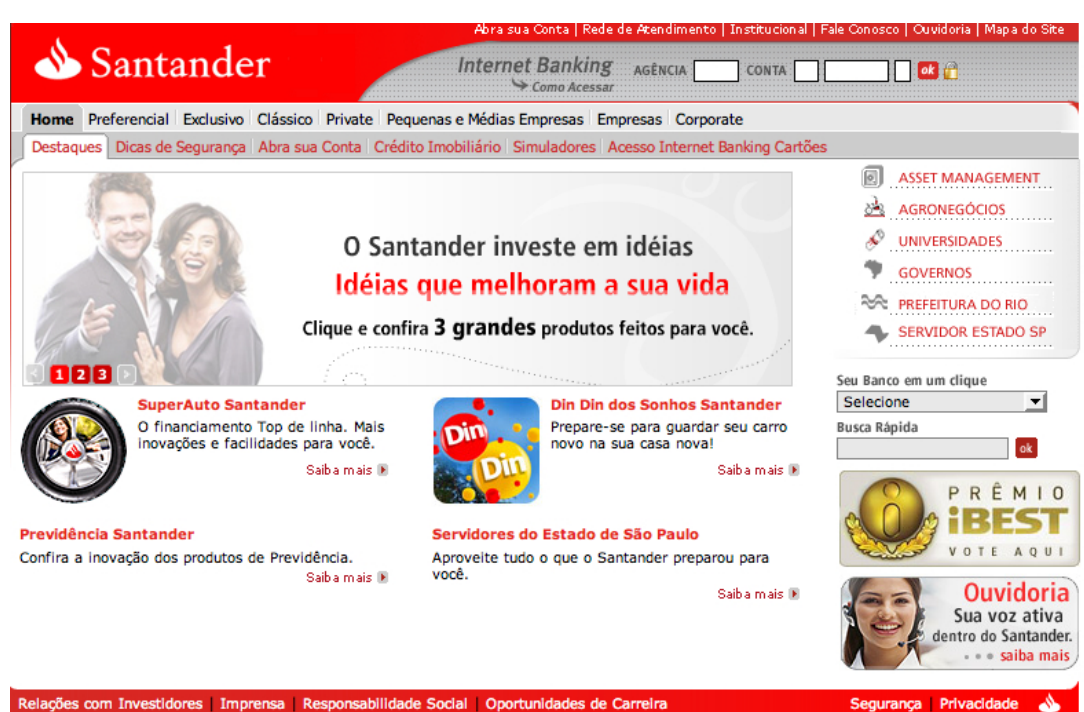
Figure 5. Snapshot of the Santander (Brazil) main